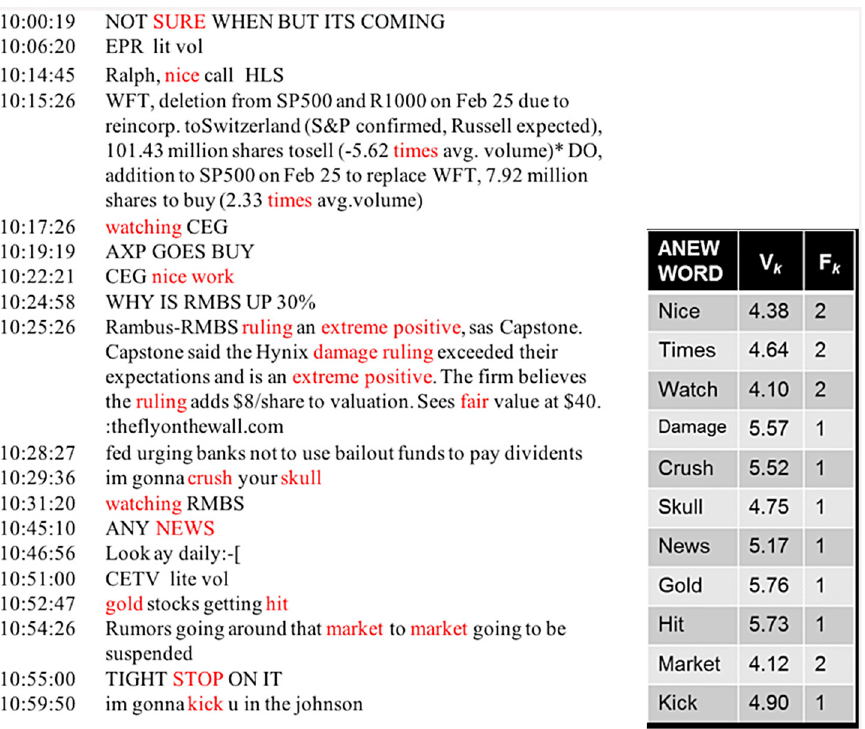
Fig 1. Instant Message Emotional Activation Coding. Left panel contains an actual Instant Message (IM) conversation as recorded in our data for a trader. Words highlighted in red are words in the ANEW dictionary that reflect a level of emotional activation over our threshold. Right panel indicates how an emotional activation level is computed for a selection of words that appear in the instant message conversation and the ANEW